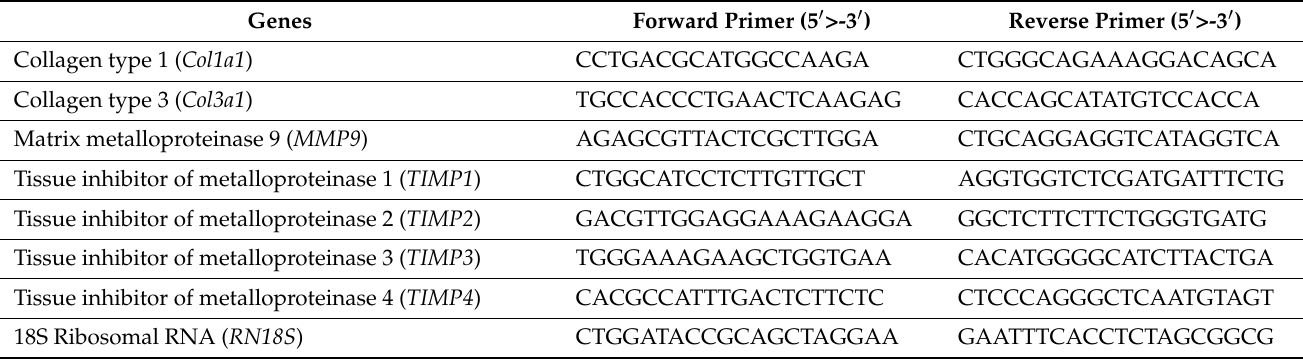
Table 1. Primers of the targeted